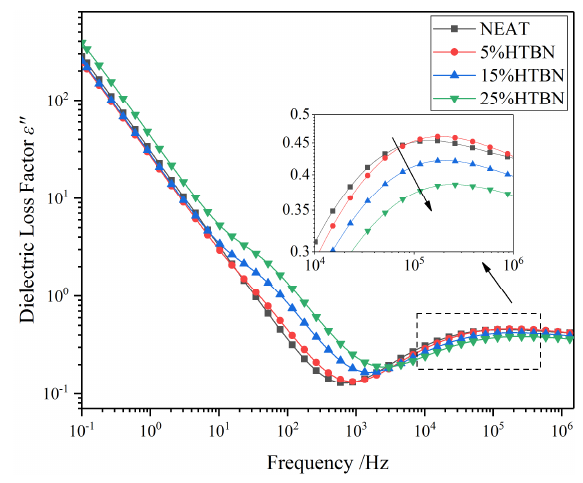
Figure 7. Frequency spectrum characteristics of dielectric loss factor with different HTBN contents at 90 °C.